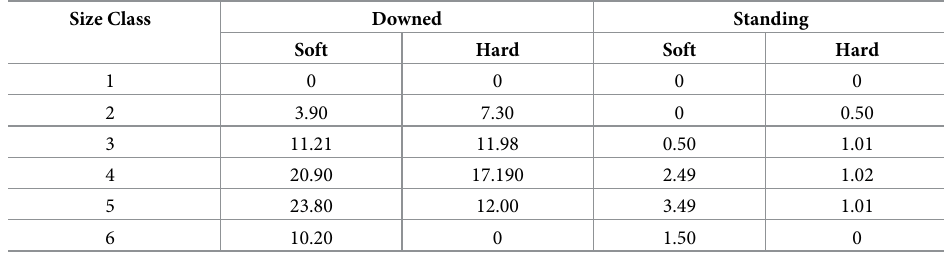
Table 3. CWD mass of each size class on WS80 � . Size Class Downed Standing Soft Hard Soft